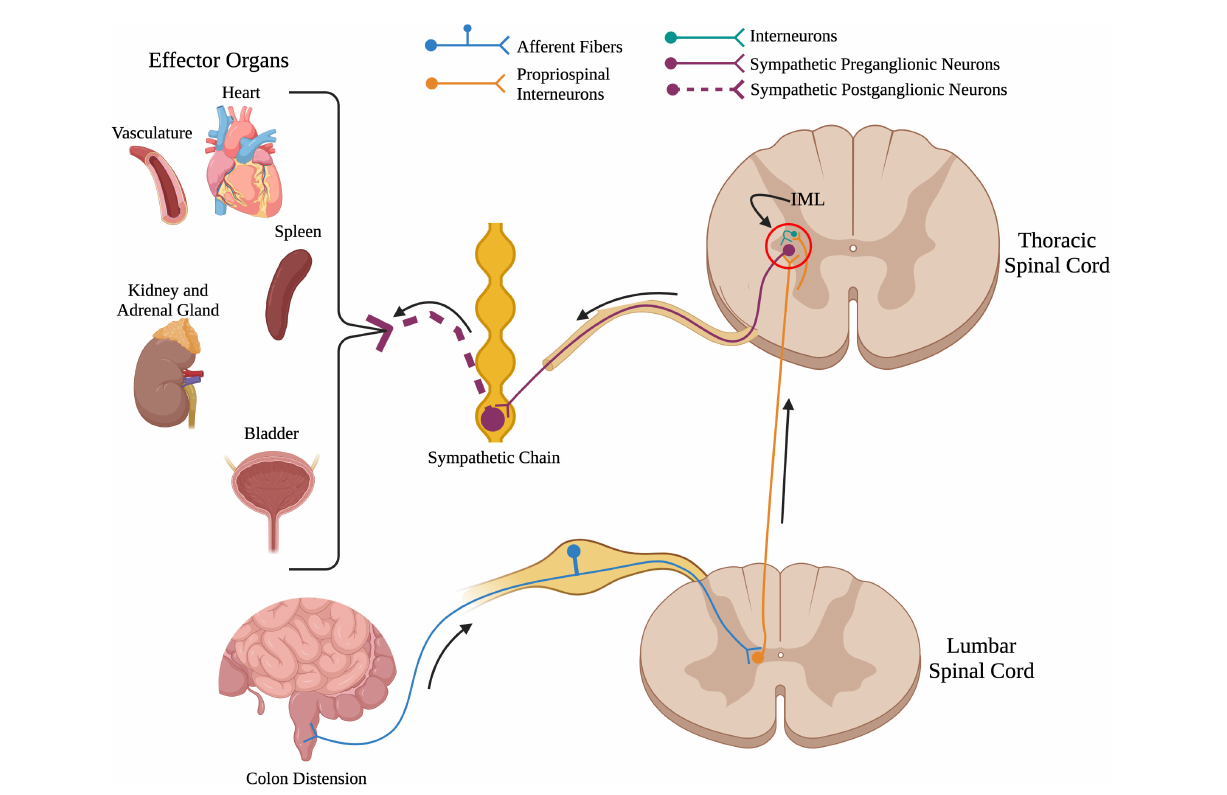
FIGURE2 Overview of the spinal sympathetic circuit. When there is a stimuli below the level of injury such as colon distension in the above example, primary afferent fibers from that organ travel into the spinal cord and synapse onto propriospinal interneurons located near the central canal. From here, propriospinal interneurons travel rostrally across many spinal segments to synapse upon either (1) sympathetic preganglionic neurons located in the intermediolateral cell column, or (2) interneurons located near sympathetic preganglionic neurons. Sympathetic preganglionic neurons project out to the sympathetic chain to synapse onto sympathetic postganglionic neurons that innervate target organs in the periphery. (Created using